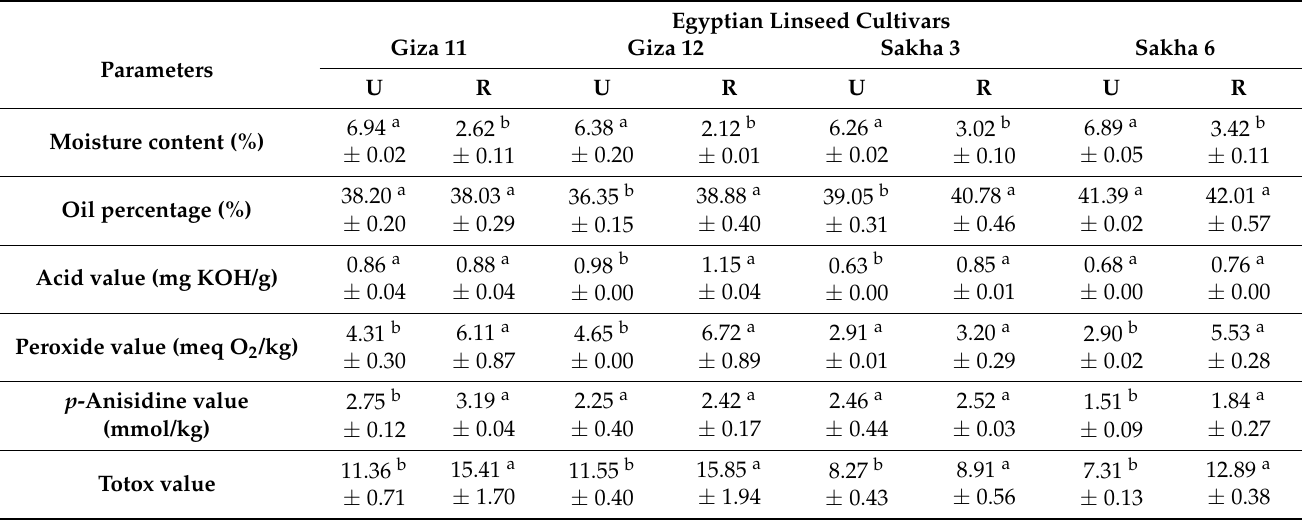
Table 1. Physicochemical characteristics of oils extracted from four Egyptian unroasted and roasted linseed